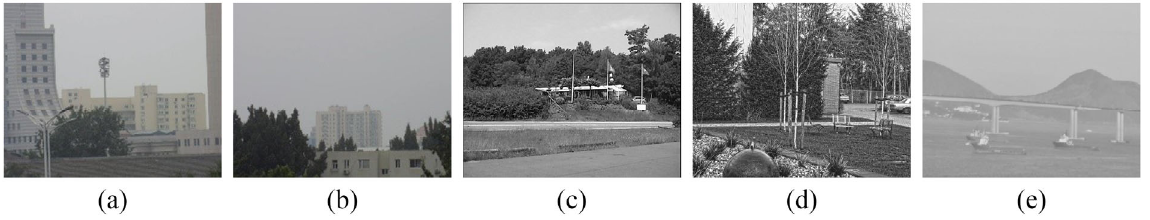
Figure 11. Five sets of scenes chosen for demonstrating the effectiveness of the evaluation function and search algorithm: ( a ) urban scene; ( b ) urban scene with a large open view; ( c ) forest scene; ( d ) park scene; ( e ) bay